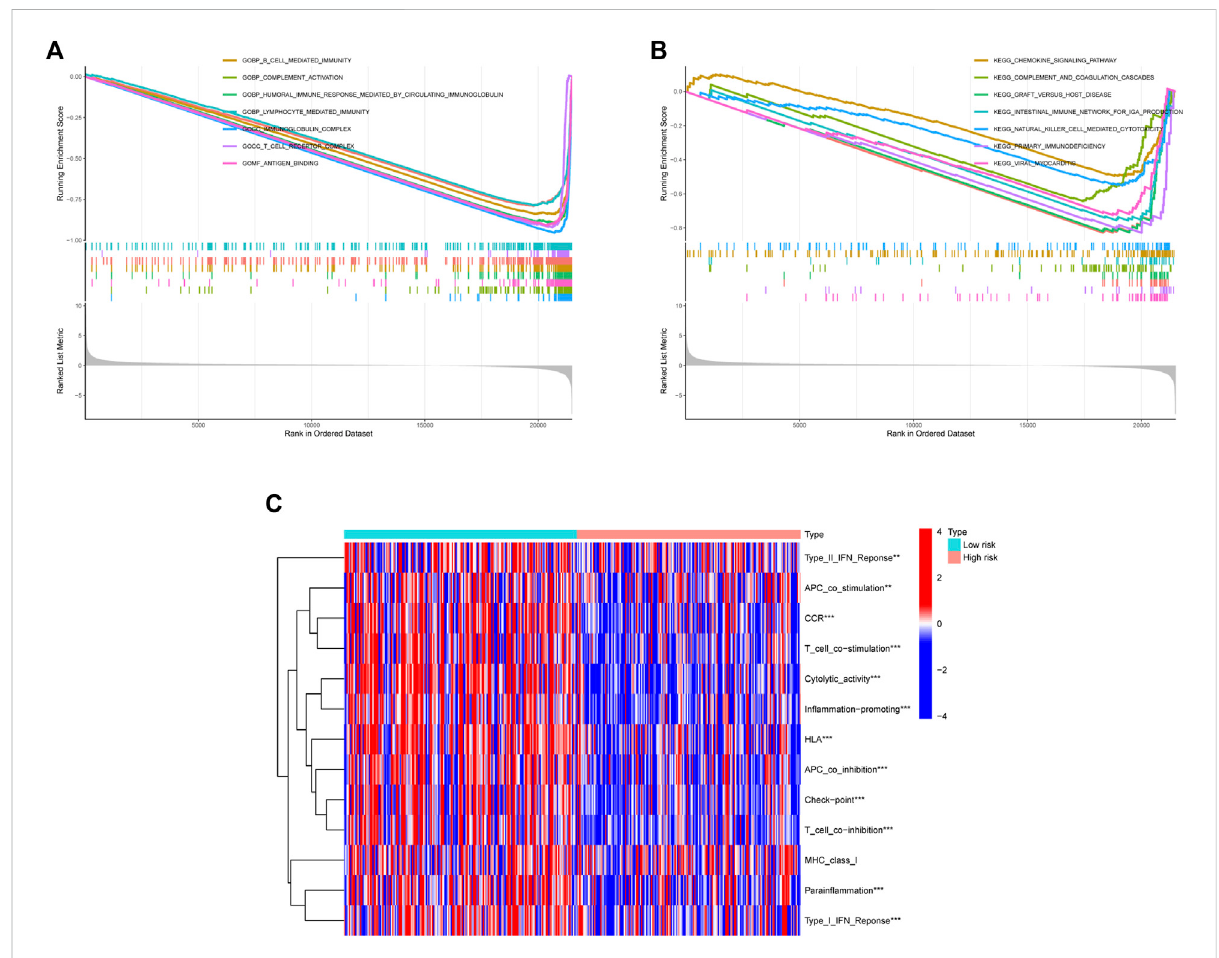
FIGURE 7 The results of enrichment analysis. (A) Enrichment analysis of GO. (B) Enrichment analysis of KEGG. (C) ssGSEA immune function enrichment analysis.